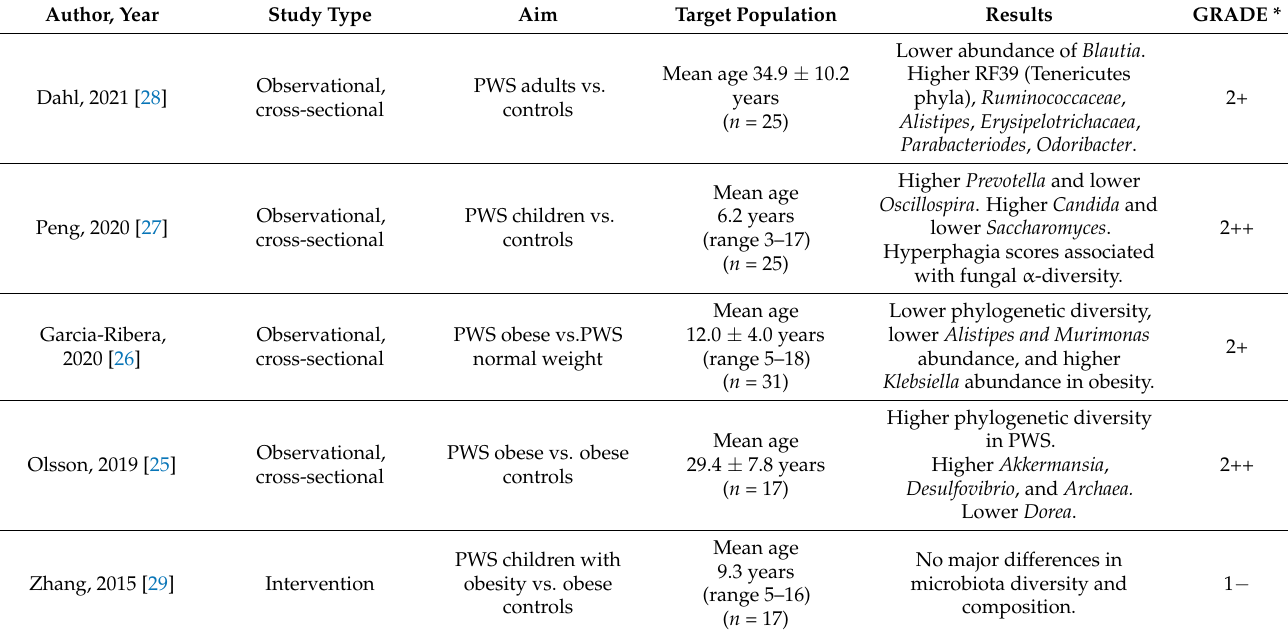
Table 1. Studies characterizing the gut microbiome in subjects with PWS.